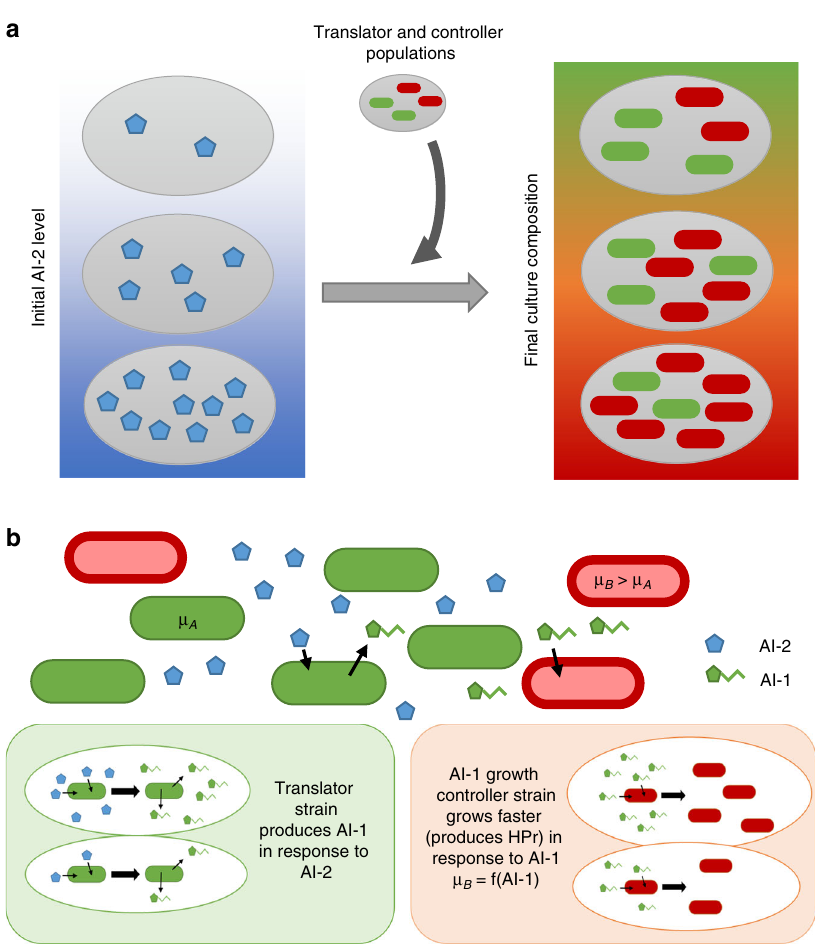
Fig. 1 Design of autonomously regulated co-culture. a Engineered co-culture with AI-2 regulated composition. When the translator and controller populations are added to environments with AI-2, the resulting culture composition varies based on the AI-2 level. b Depiction of each strain in engineered co-culture. The translator strain senses AI-2 level and produces AI-1. The AI-1 growth controller strain produces HPr in response to AI-1, which alters cell growth rate and changes the culture